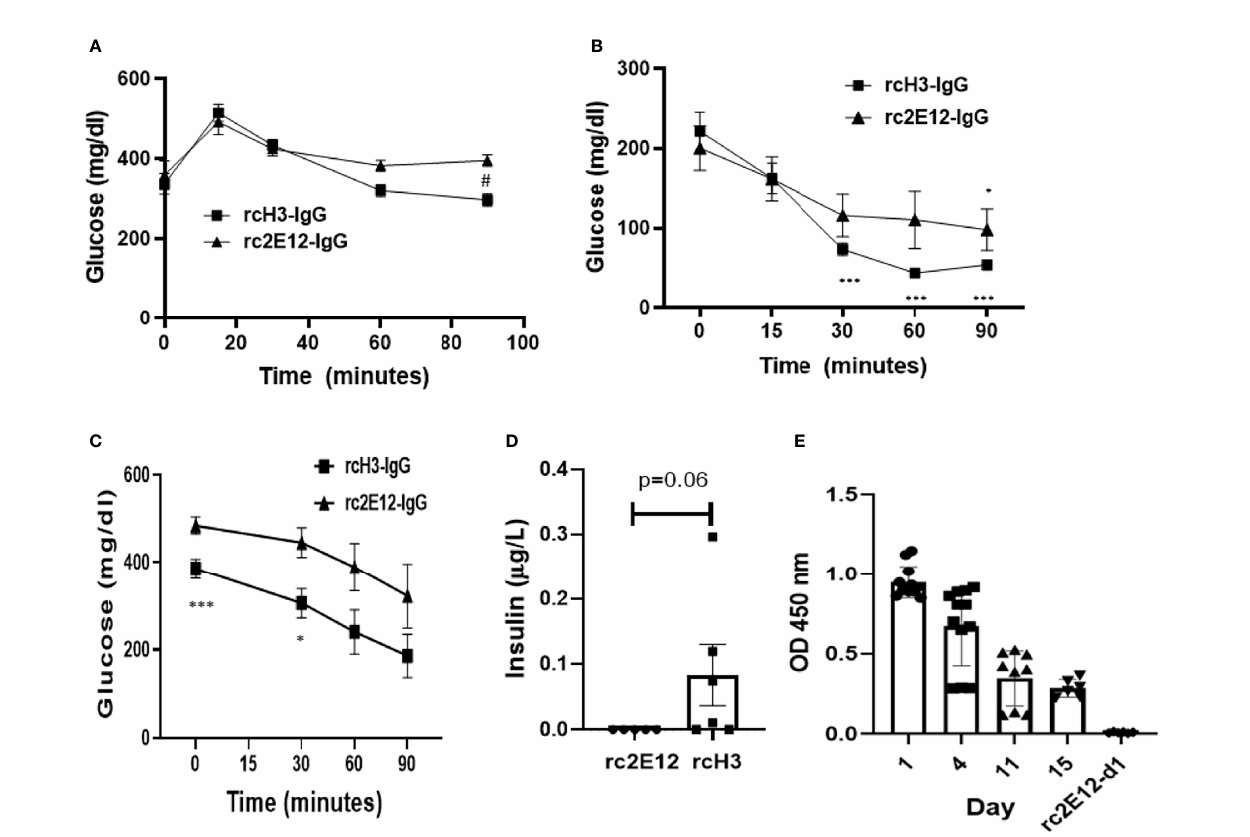
FIGURE 5 | The reverse-chimeric IDE-speci fi c antibody H3 increases blood insulin levels and reduces blood glucose levels in STZ-induced diabetic mice. (A) Two days after STZ injection, mice were administrated i.p. with IDE-speci fi c antibody or control antibody and were tested by (A) oGTT assay (n = 5 – 6 mice in each group, # p < 0.01 between groups) or (B) ITT assay (n = 5 mice in each group, *p < 0.05, ***p < 0.001 within group). (C) ITT assay following 11 days of antibody administration in STZ-treated mice (n = 5 – 6 mice in each group, *p = 0.015, ***p = 0.008). (D) Insulin serum levels following 11 days of antibody administration in STZ-treated mice assessed by Mercodia ultrasensitive mouse insulin ELISA. The results are presented as mean ± SEM. (E) Levels of IDE-speci fi c antibodies at different days following administration (n = 2 – 4 mice in each group). The results are presented as mean ±